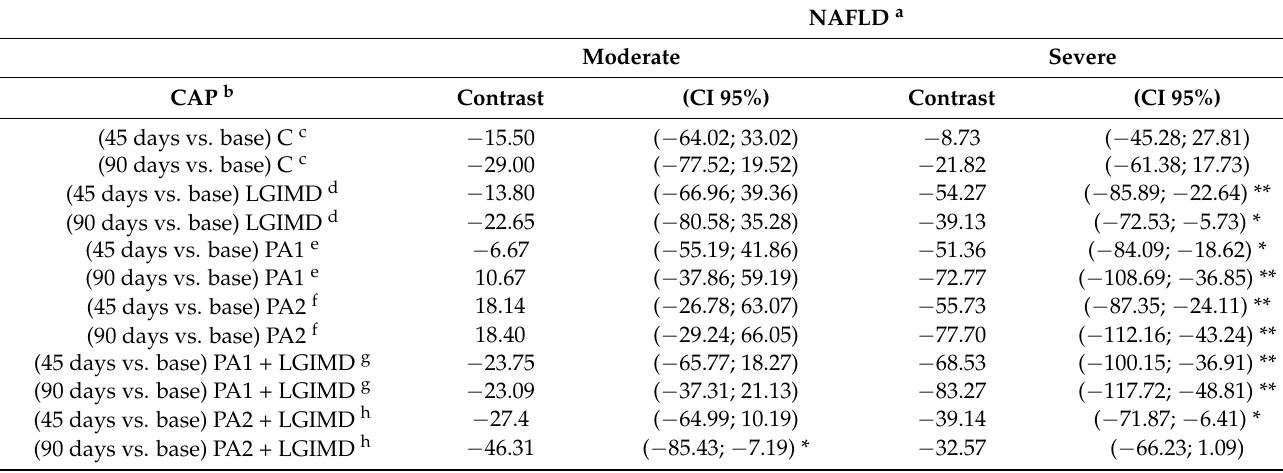
Table 7. Repeated Measures Analysis of Variance. Effect of Treatments on NAFLD Scores (assessed by CAP value) by, Time and NAFLD Severity. NutriAtt Trial, Castellana Grotte,